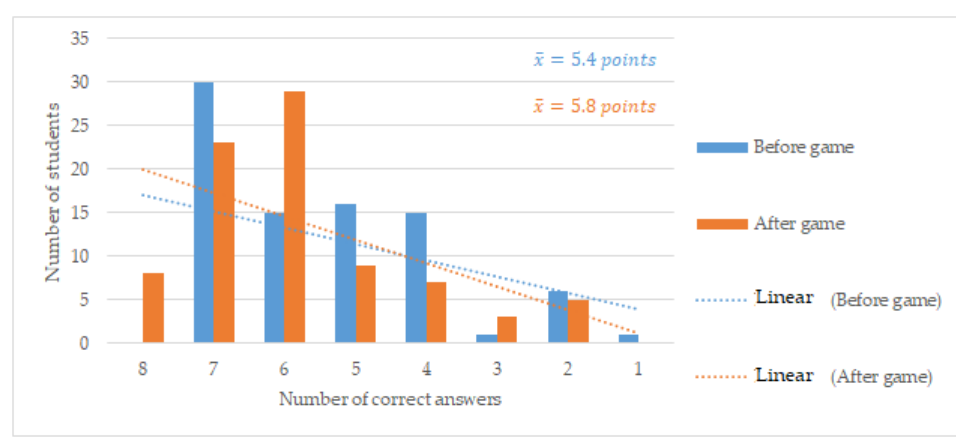
Figure 4. Results of questionnaire for knowledge